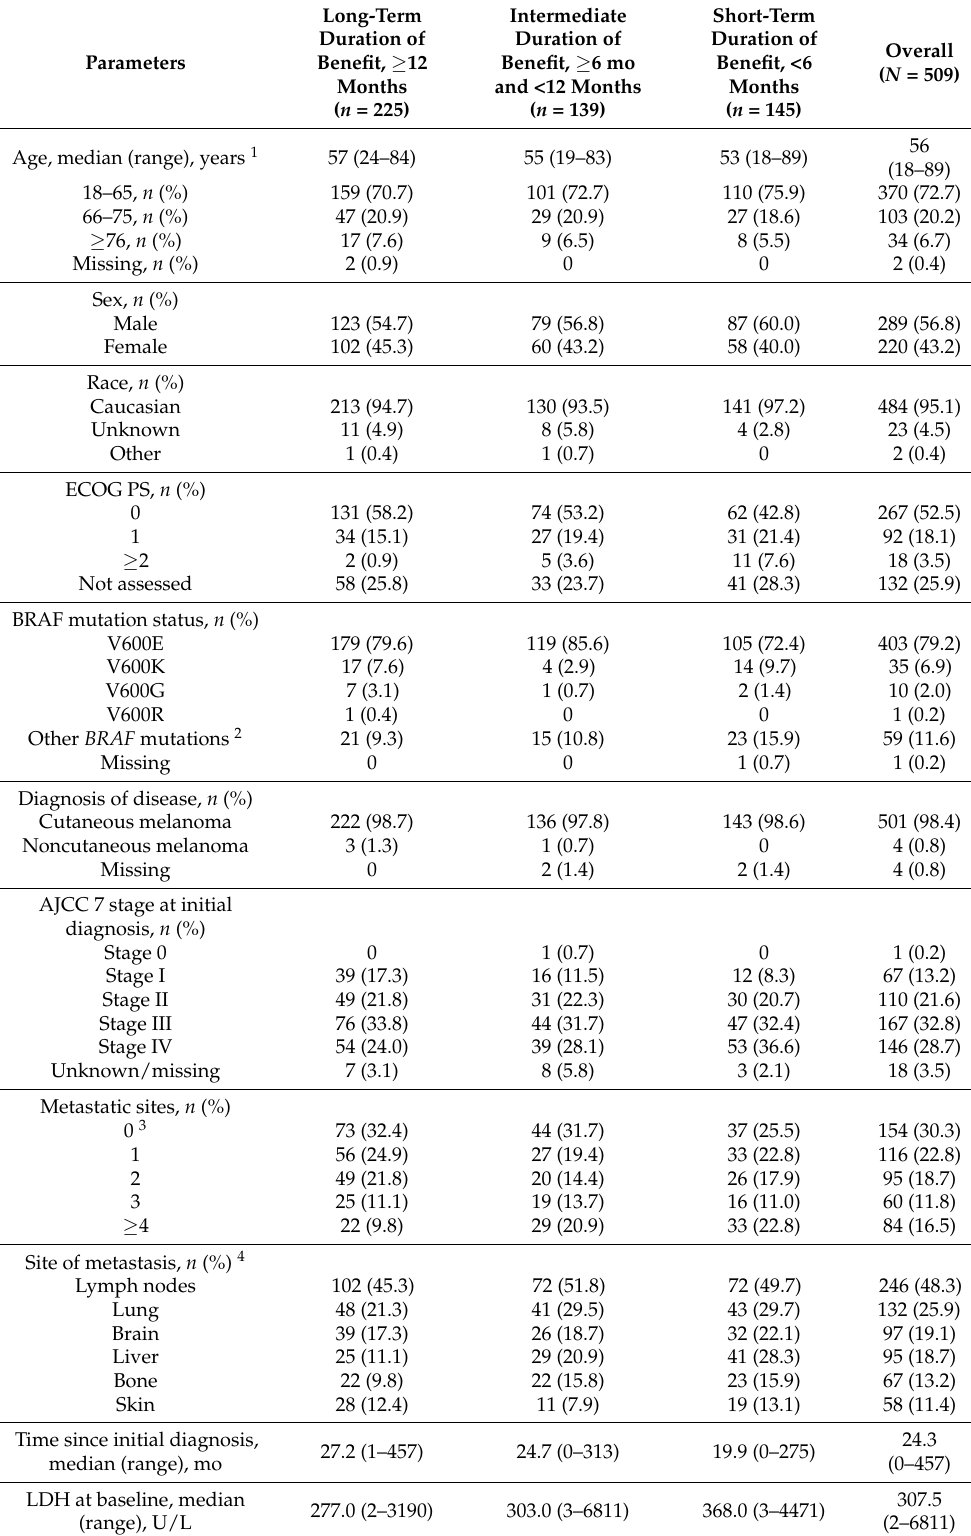
Table 1. Baseline and disease characteristics of patients in the benefit